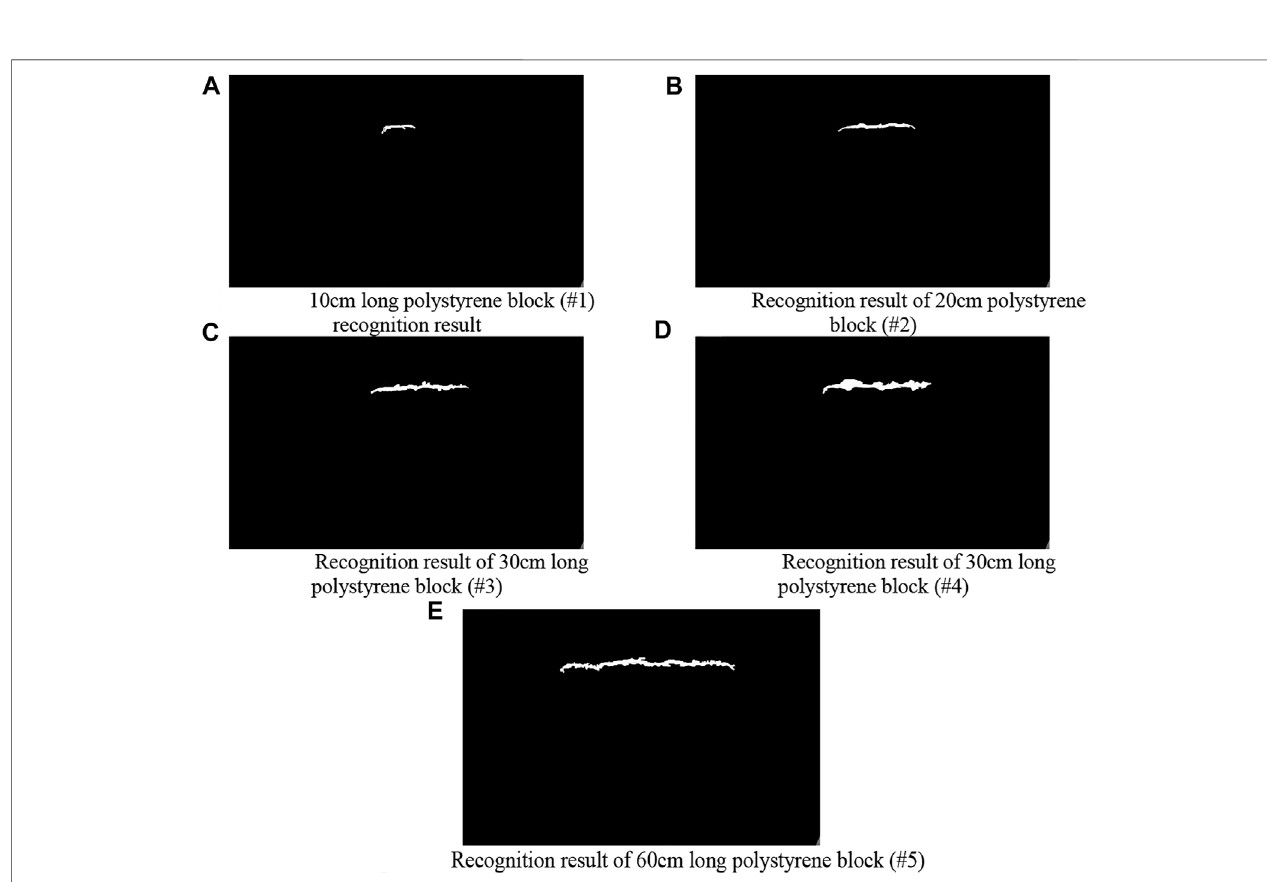
FIGURE10| Voidarearecognitionalgorithmtoidentifythemaximumareasignalpro fi leofthepolystyreneblock. (A) 10-cm-longpolystyreneblock(#1)recognition result. (B) Recognition result of the 20-cm polystyrene block (#2). (C) Recognition result of the 30-cm-long polystyrene block (#3). (D) Recognition result of the 30-cm- long polystyrene block. (#4) (E) Recognition result of the 60-cm-long polystyrene block (#5).